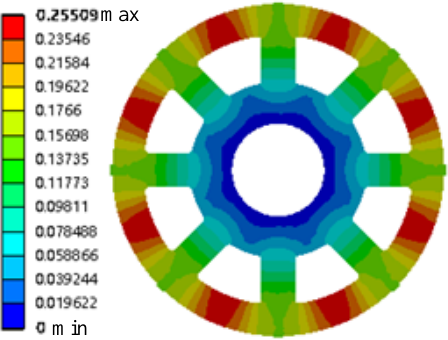
Figure 19. Strain distribution diagram of the rotor runaway condition.